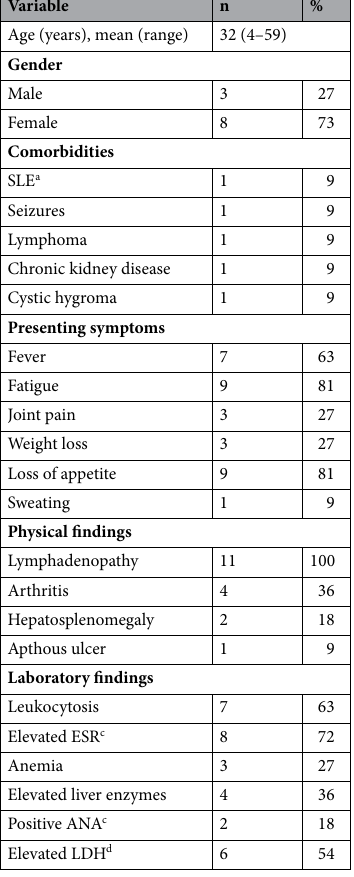
Table 1. King Abdullah University Hospital KFD Patients’ demographic and clinical characteristics. a Systemic lupus erythromatosus. b Erythrocyte sedimentation rate. c Antinuclear antibodies. d Lactate